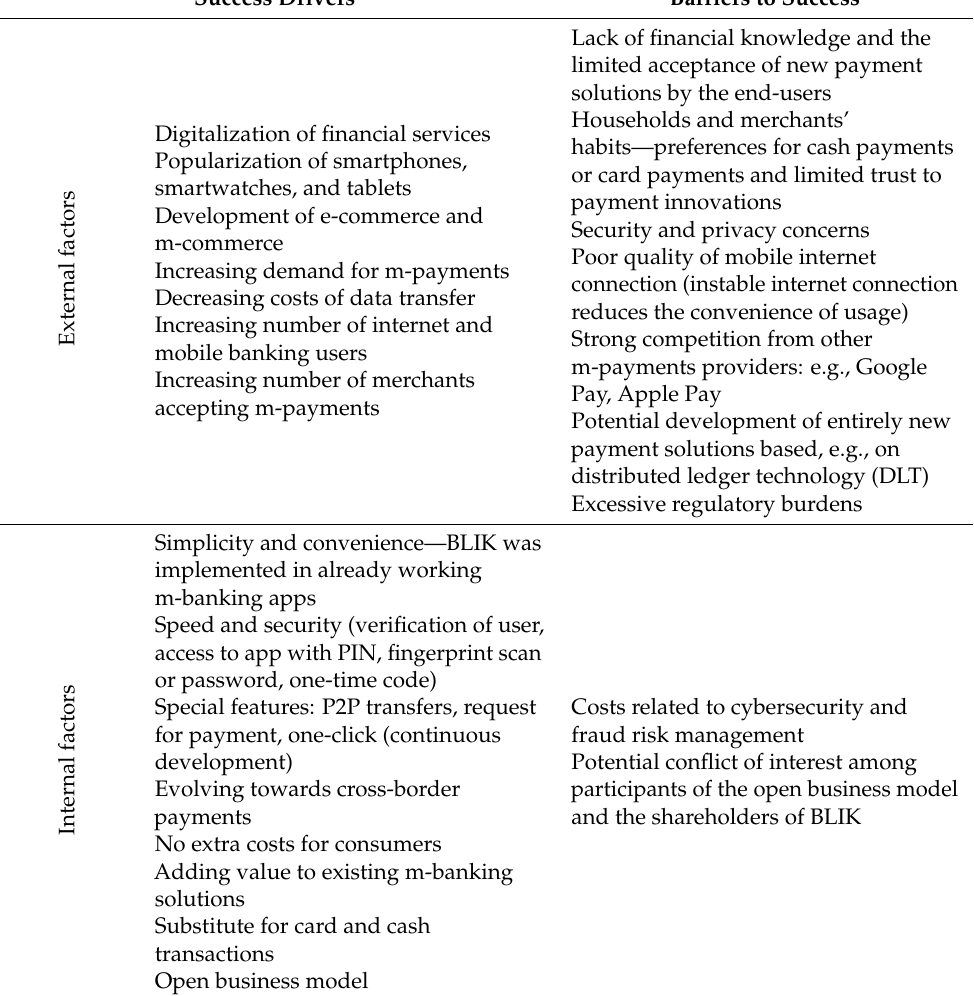
Table 9. Determinants of BLIK market